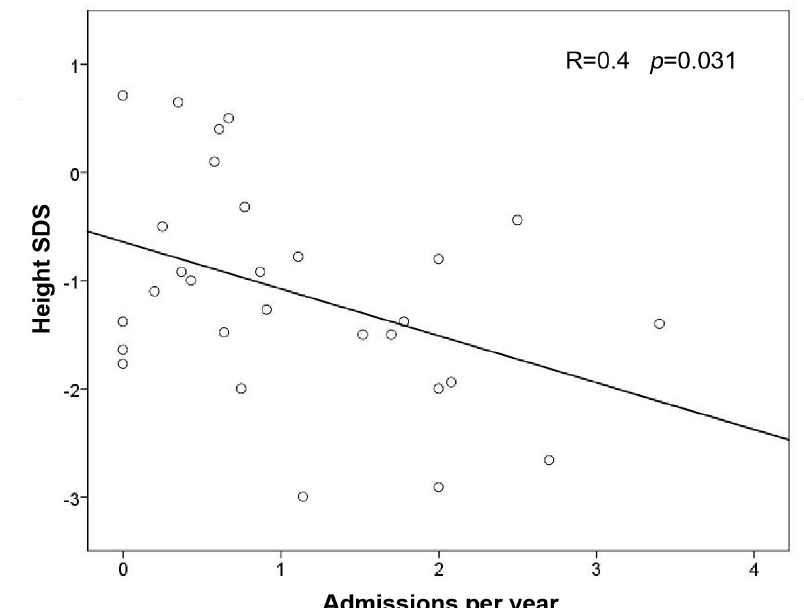
Figure 4. Correlation between last height SDS and number of admissions per